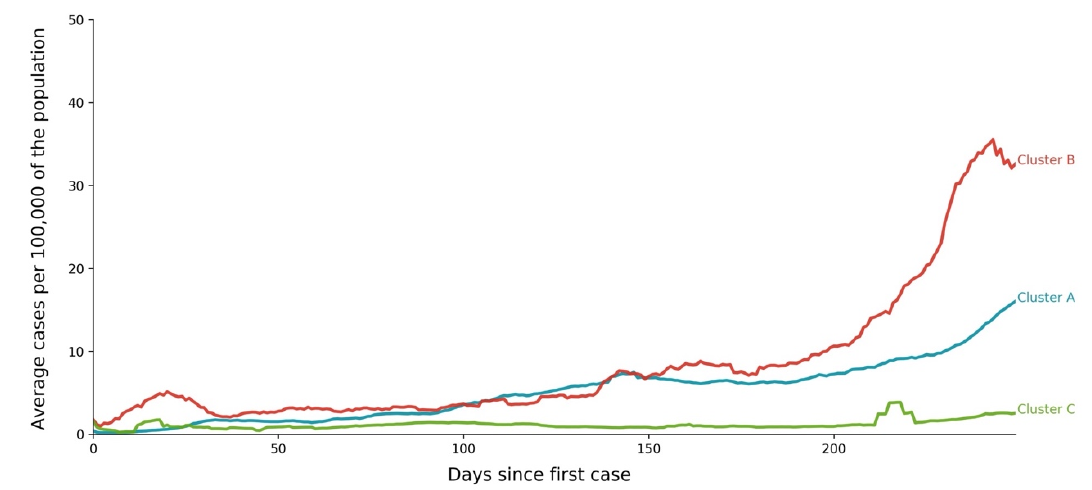
Figure 6. Seven days moving averages of cases per 100,000 people in each cluster over time.